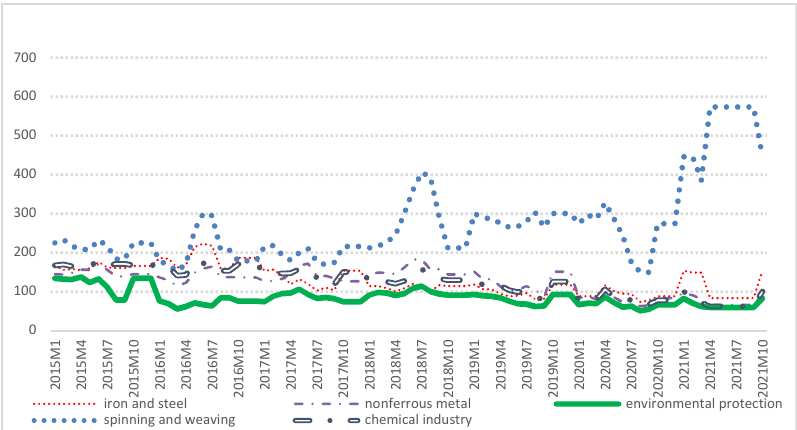
Figure 3. Credit spread (median): industrial debt.